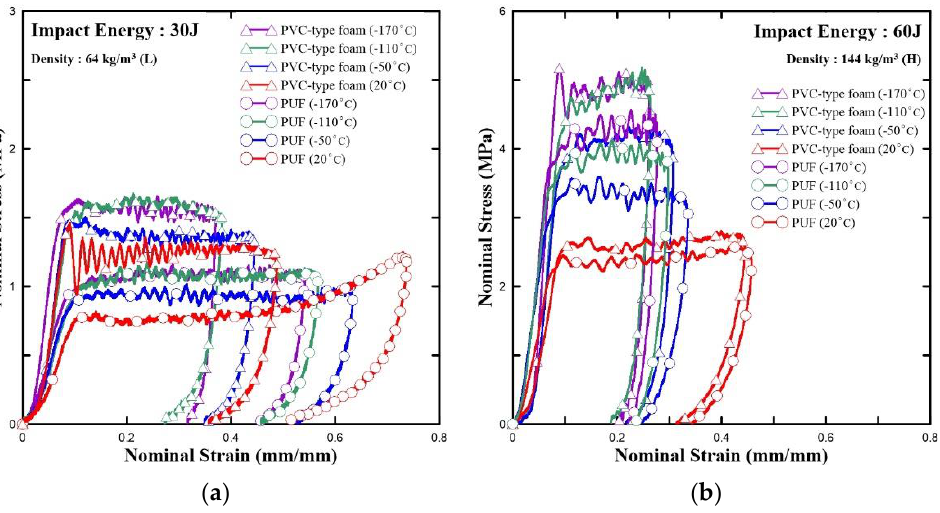
Figure 12. Stress – strain curve based on the results of the impact test: (a) 30J and (b) 60J of impact Figure 12. Stress–strain curve based on the results of the impact test: ( a ) 30 J and ( b ) 60 J of energy. impact